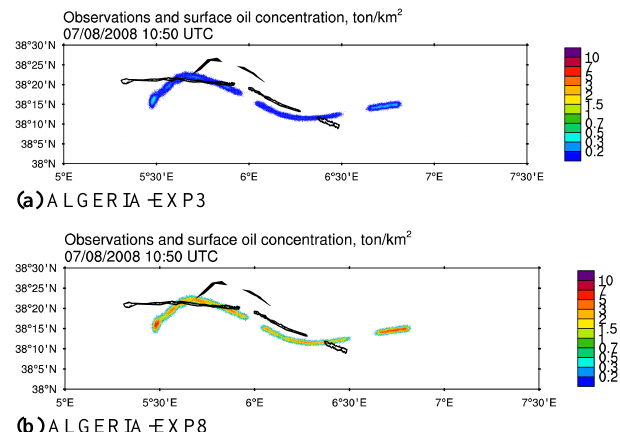
Fig. 11. Results of sensitivity experiments to oil type, age and thick- ness: superimposition of the initial slick observed by SAR (white slick with black contour) on 6 August 2008 at 09:51 UTC, the slick observed by MODIS (black slick) 7 August 2008 at 10:50 UTC and the corresponding MEDSLIK-II-predicted position and concentra- tion: (a) simulated slick with oil API=45, thin slick thickness 1µm and age of 24h; (b) simulated slick with oil API=22, thin slick thickness 10µm and age of 24h.